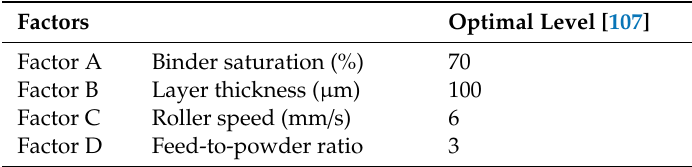
Table 17. Optimization of binder jetting parameters using Taguchi